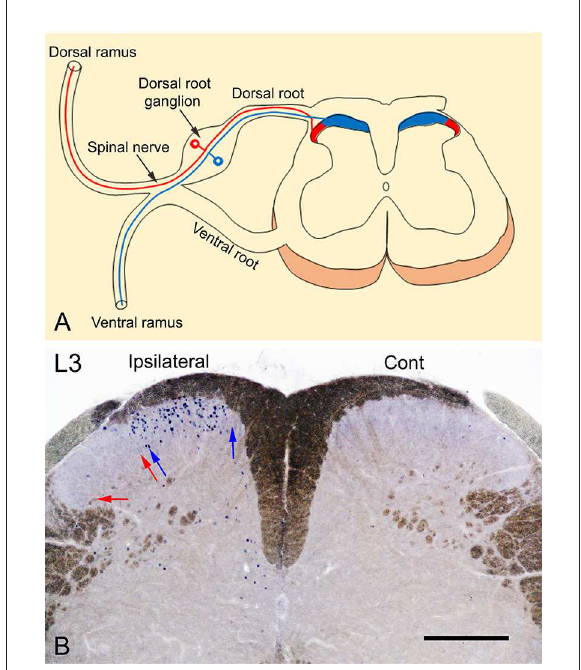
FIGURE1 (A) Somatotopic arrangement of the termination of primary afferent fibers. Primary afferents of the dorsal ramus terminate in the lateral 1/3 (red) while those from the ventral ramus, terminate in the medial 2/3 (blue) of the superficial layer of the dorsal horn of the spinal cord. (B) A transverse section of L3 spinal segment showing the neuronal expression of c-Fos in response to noxious heat stimulation by immersion of the left foot in 52 ◦ C hot water bath. The photography was intentionally carried out without dehydration of the sections to reveal the myelinated fibers (brown color) and to show a clear demarcation of the dorsal horn of the spinal cord. The expression of c-Fos is observed only in the medial 1/2 of the superficial layers (laminae I-II) of the ipsilateral dorsal horn marked between blue arrows where the primary afferents of the foot terminate. In comparison, no c-Fos expression could be observed in the lateral 1/2 of the dorsal horn marked between red arrows where the primary afferents of the back on the body terminate or in the contralateral control side. Scale bar = 250 µ